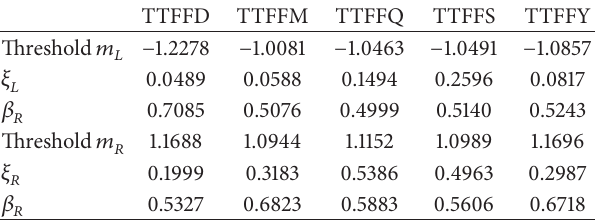
Table 3: Parameter estimation for each natural gas’s residuals.